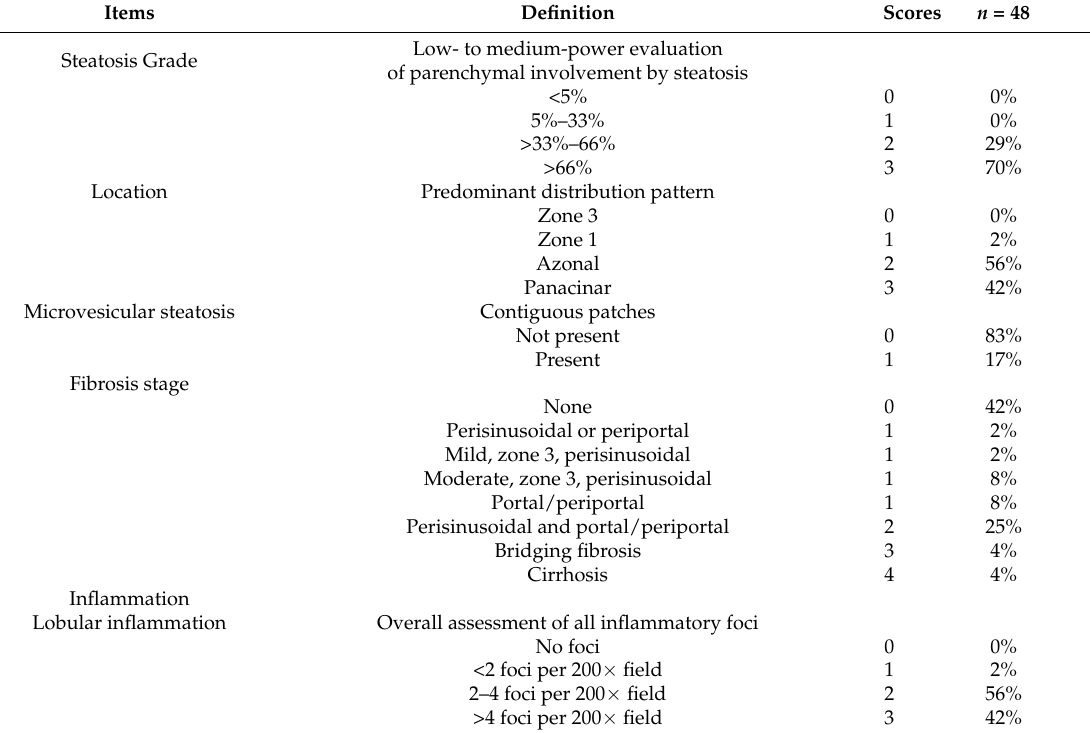
Table 3. NASH model evaluated by NASH Research Network Scoring System Definitions and Scores in Study